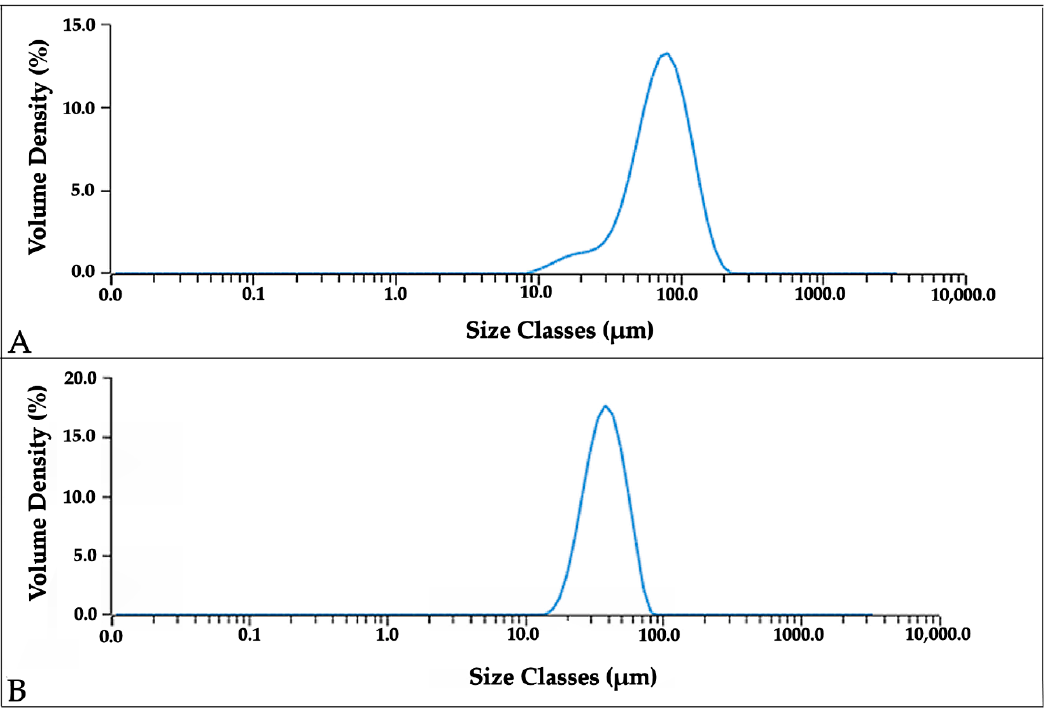
Figure 2. Particle size distribution of the Co–Cr–Mo ( A ) and Ti–6Al–4V ( B ) powders.